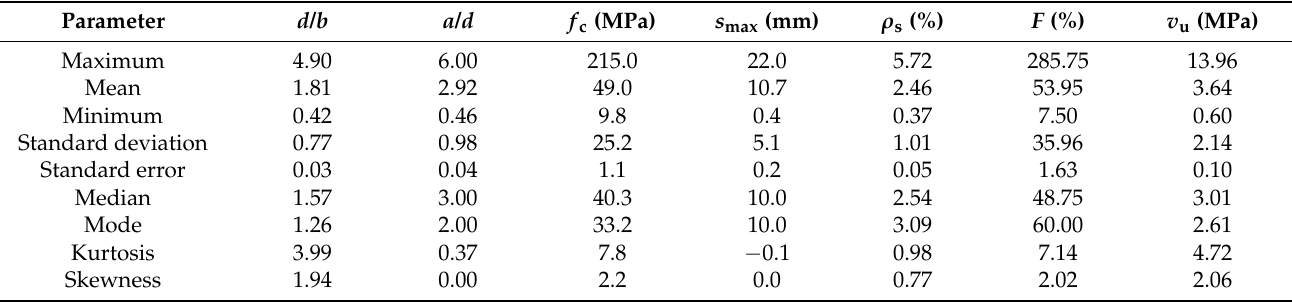
Table 1. Descriptive statistics of variables in the